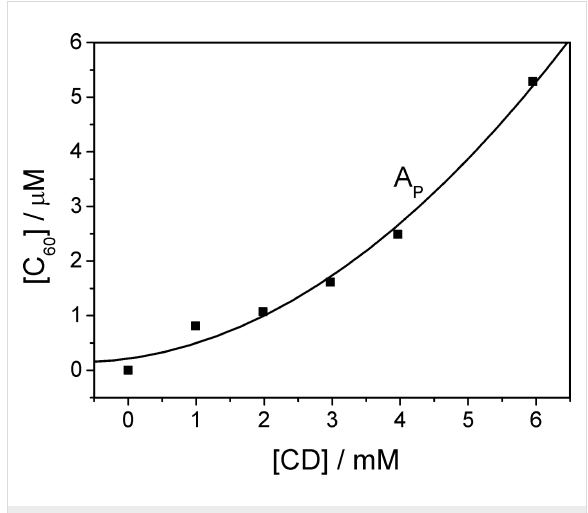
Figure 4: Phase-solubility diagram of C 60 in aqueous solution in the presence of CD 3 .